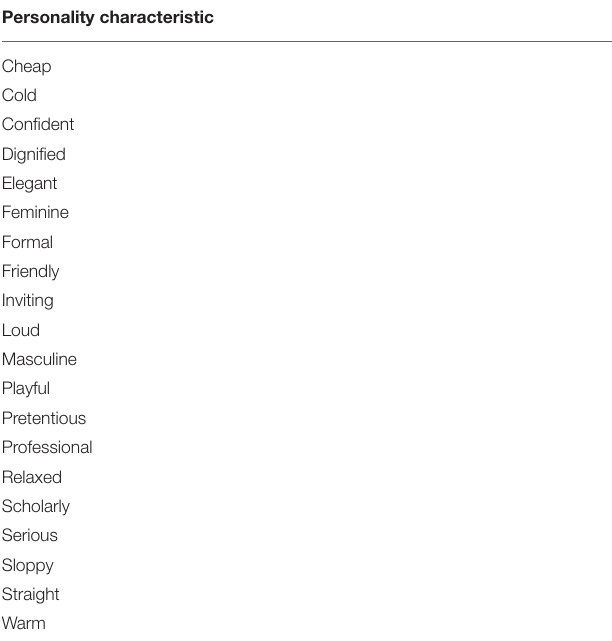
TABLE 2 | The print personality characteristics used in this study. Personality